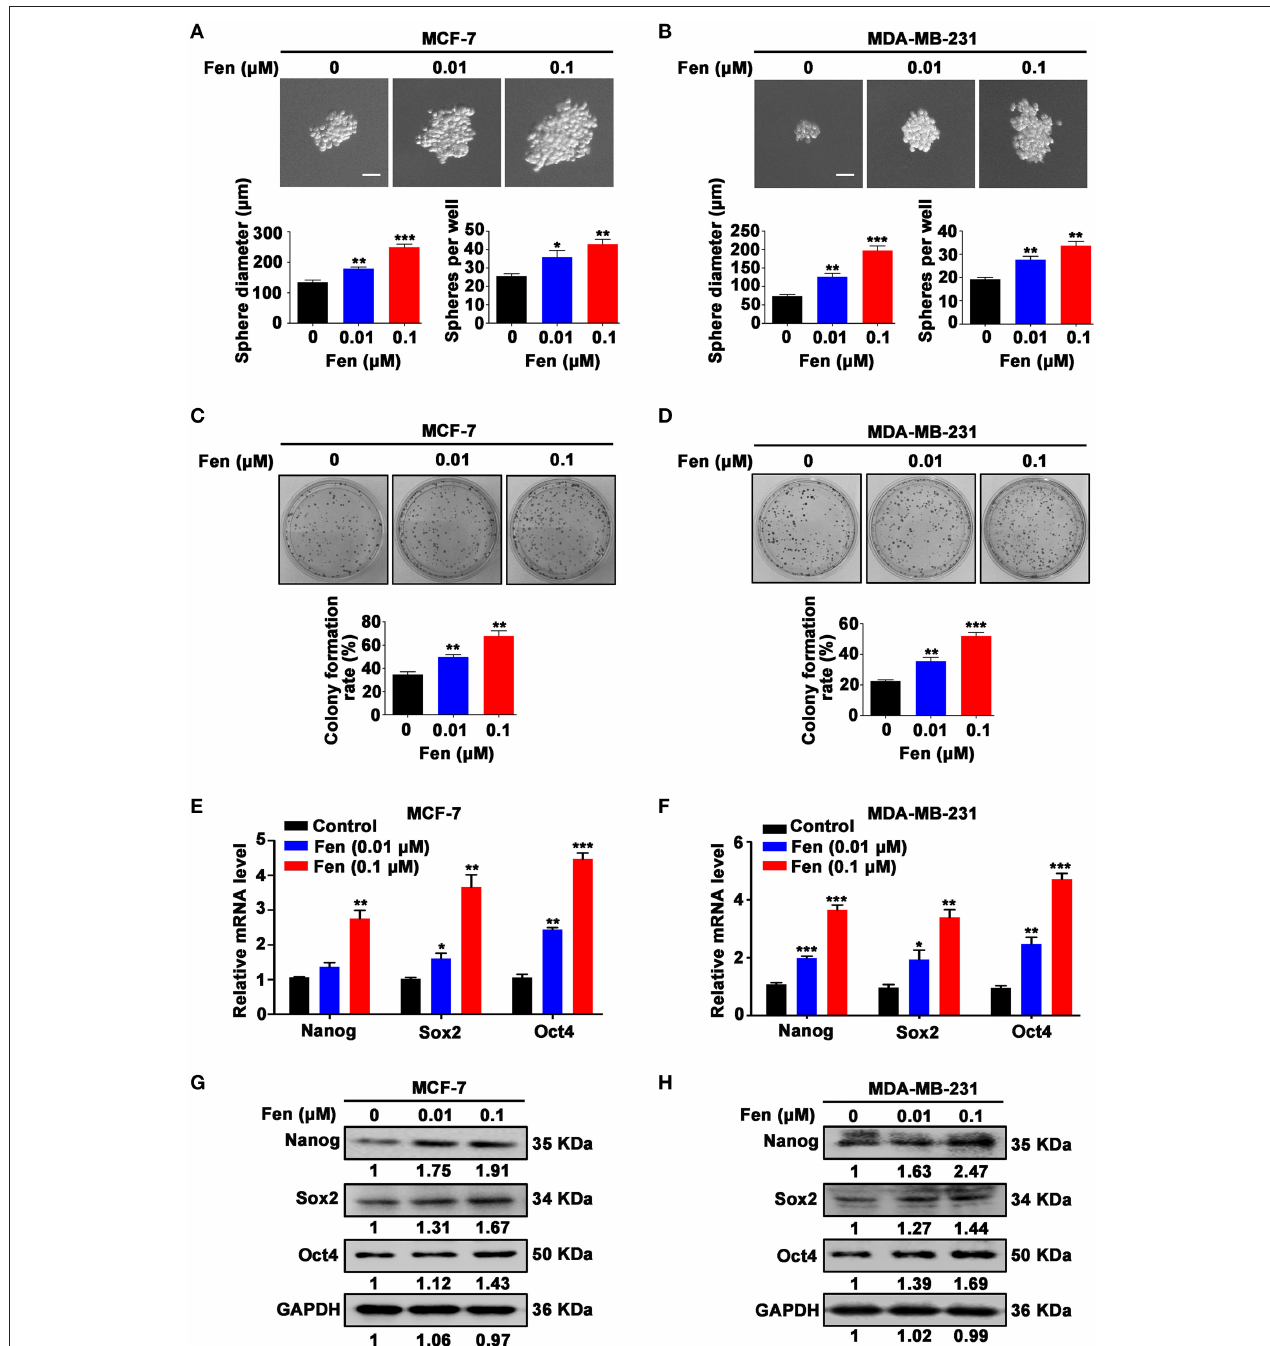
FIGURE 1 | Fentanyl promotes stemness of breast cancer cells. (A,B) Representative images of tumor-spheres in MCF-7 and MDA-MB-231 cells under a microscope after treatment with fentanyl (0, 0.01 µ M, 0.1 µ M) for 12 days. (Scale bars = 50 µ m; Magnification, 200 × ). (C,D) Images of colony formation in MCF-7 and MDA-MB-231 cells after treatment with fentanyl for 10 days. (E,F) qPCR and ( G,H) Western blot analysis for Nanog, Sox2, and Oct4 gene and protein expression in MCF-7 and MDA-MB-231 cells treated with fentanyl for 48 h. Data are represented as mean ± SD ( n = 3). Statistical significant different in sphere diameter, sphere per well and colony formation rate (* P < 0.05; ** P < 0.01; *** P < 0.001).